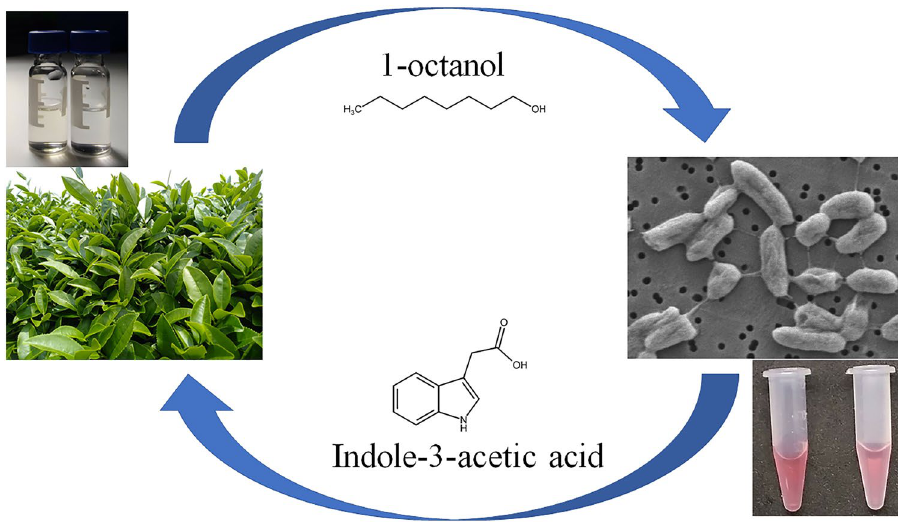
Figure 7. Schematic representation of alcohol-phytohormone exchange occurring between tea phylloplane and its bacterial inhabitant discovered in this study. Images of tea plantation, scanning electron microscopy of NEEL19 and sample vials were from this